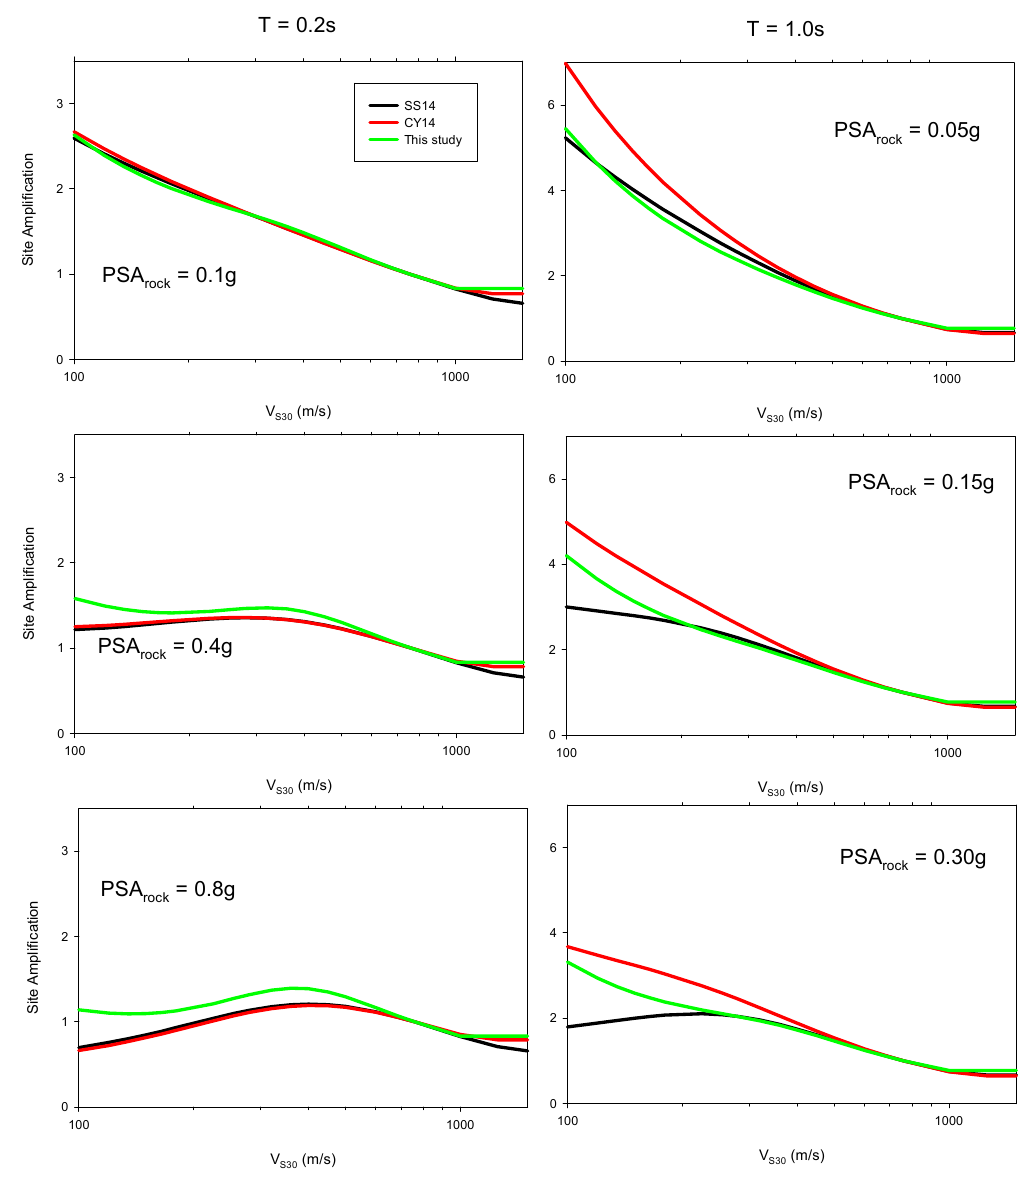
Figure 7. The comparison of the site models for weak, moderate, and strong input rock levels at 0.2 s and 1.0 s. Weak motion ( PSA rock @T0.2s = 0.1 g, PSA rock @T1.0s = 0.05 g), moderate motion ( PSA rock @T0.2s = 0.4 g, PSA rock @T1.0s = 0.15 g), and strong motion ( PSA rock @T0.2s = 0.8 g, PSA rock @T1.0s = 0.30 g). Deep soil effect is not